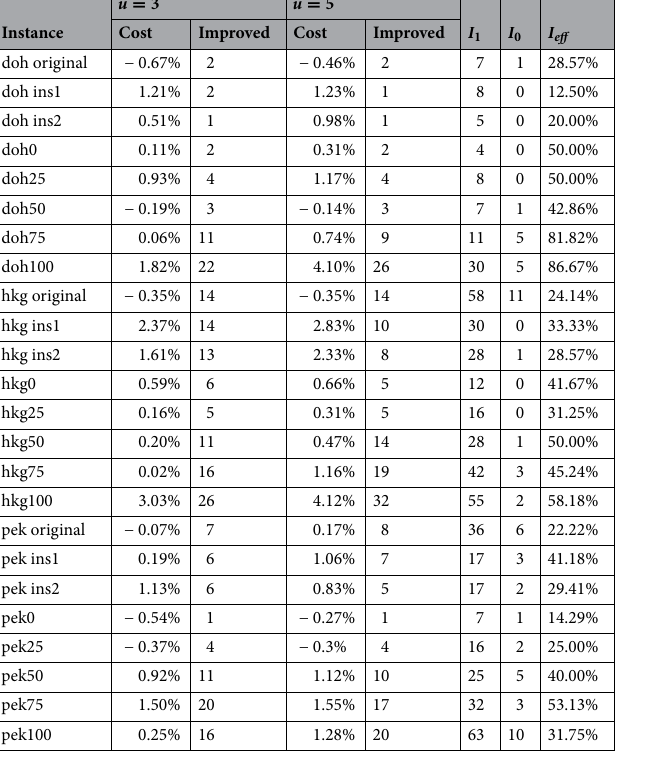
Table 4. Results for experiments with different values of u